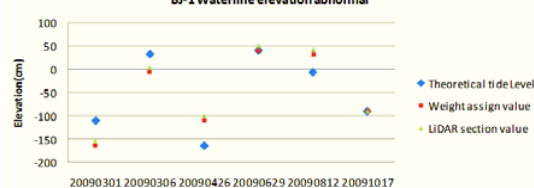
Figure.6 BJ-1 Waterline elevation abnormal scatter